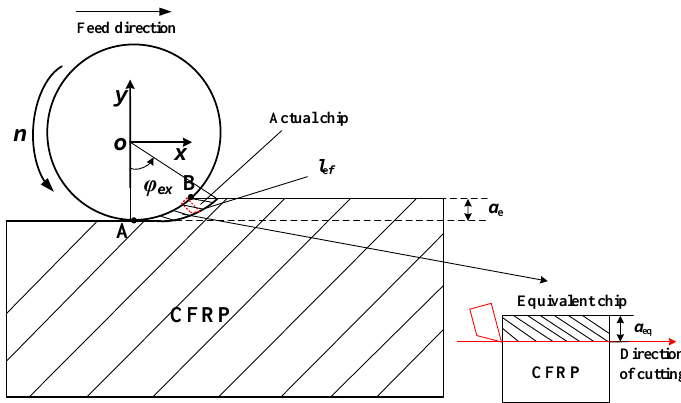
Figure 16. The schematic illustration of single-tooth cutting.